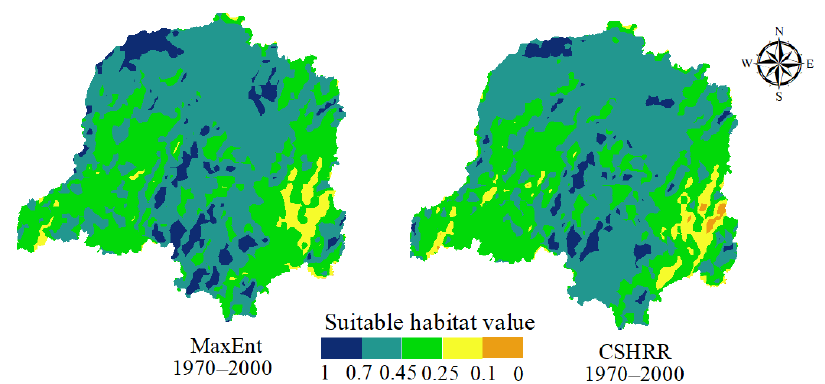
Figure 12. Vegetation habitat reconstruction under current climate (1970–2000). Note: Habitat quality values into 5 classes, including excellent (0.7–1), good (0.45–0.7), average (0.25–0.45), poor (0.1–0.25), and unsuitable habitats (0–0.1).